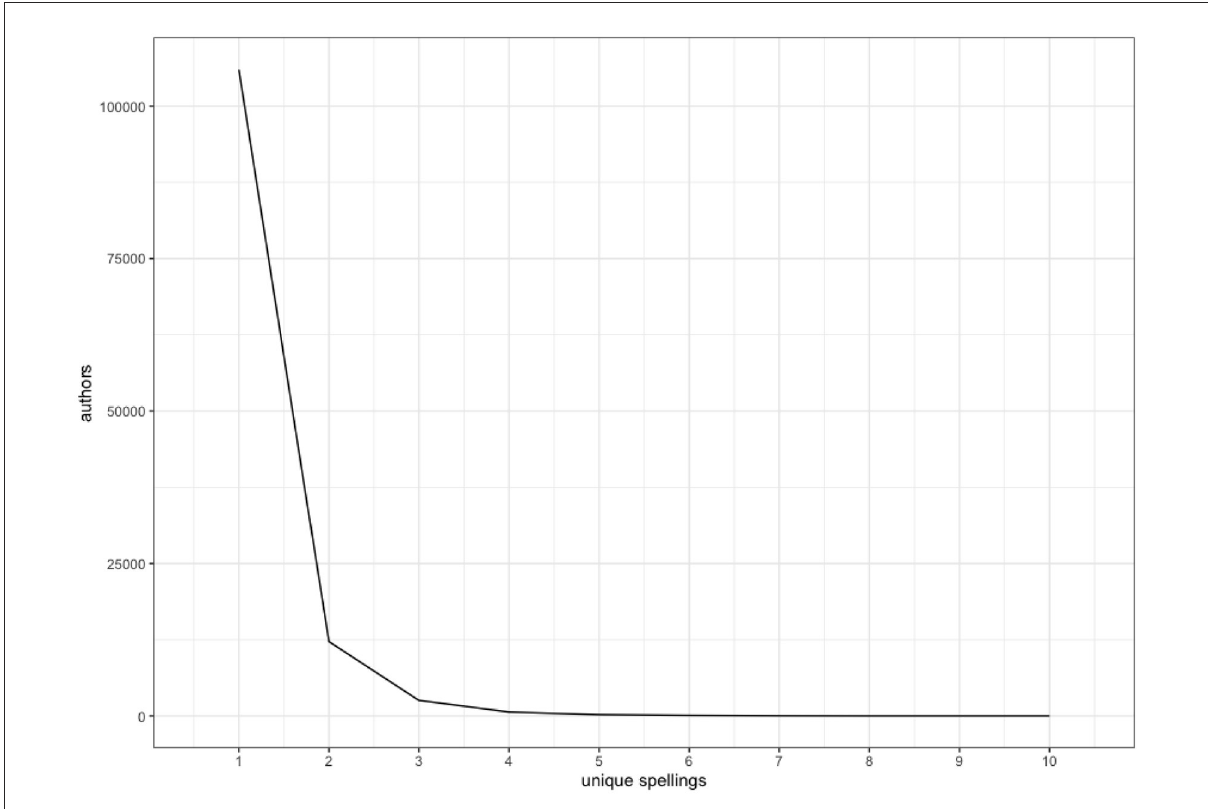
FIGURE5 Number of authors by number of unique